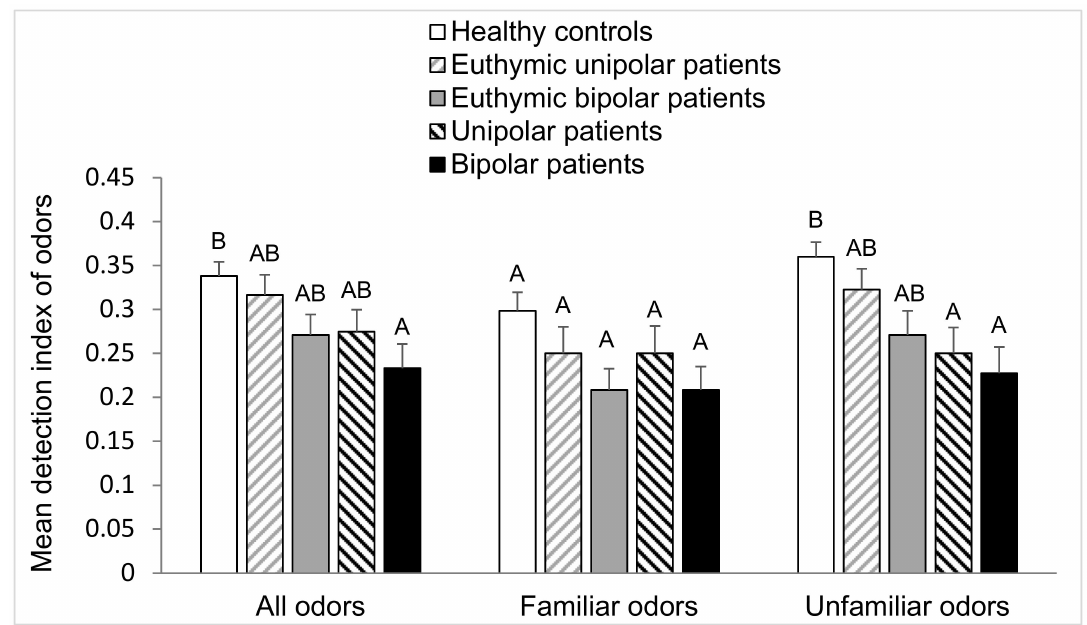
Figure 5. Between-groups comparison of mean detection indices of odors (all odors, only familiar odors, and only unfamiliar odors). For each group of odors (all, familiar, or unfamiliar), values with the same letters are not significantly di ff erent at the 5% level of significance (Tukey test). Vertical bars indicate the standard deviation of the